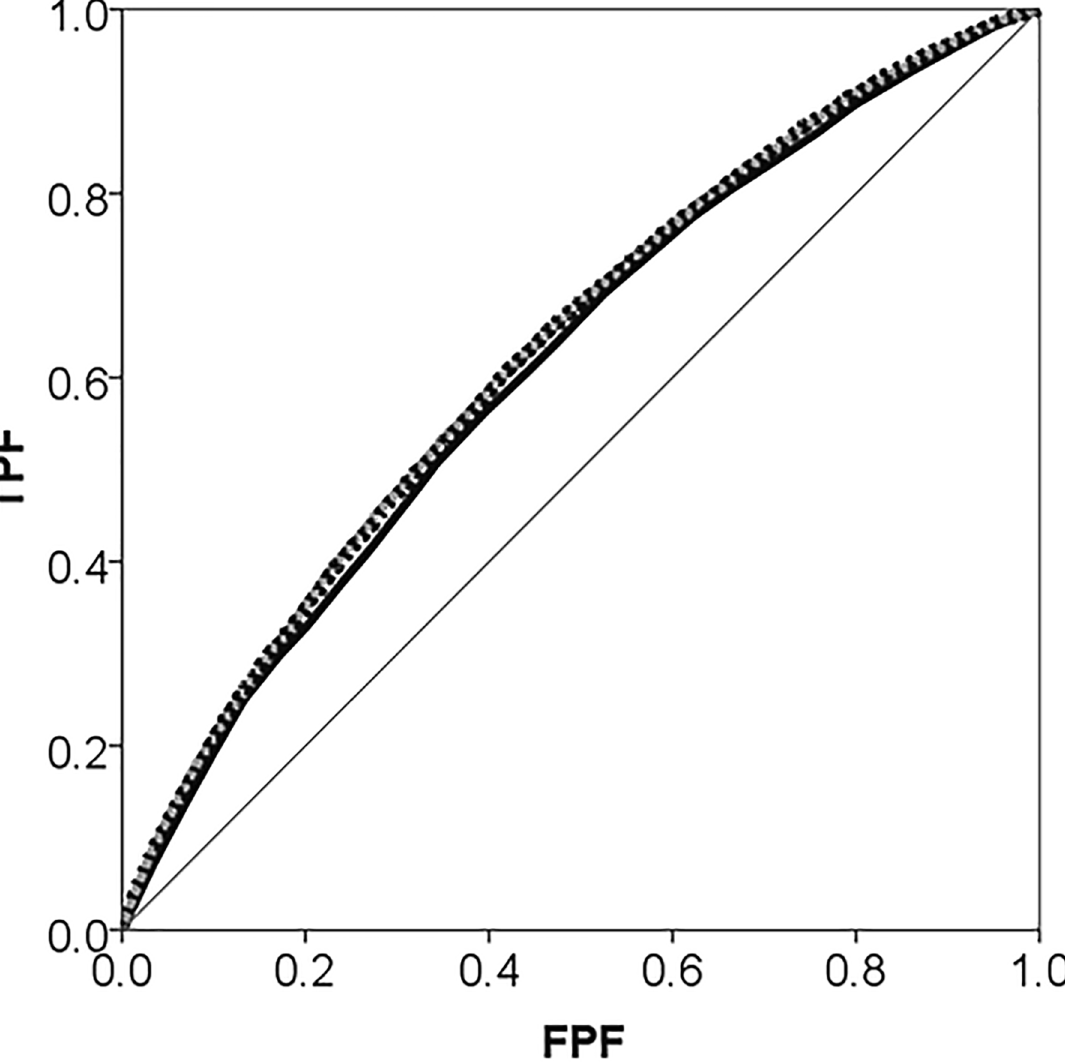
Fig 1. Areas under the receiver operating characteristic (AUC) curve for use of psychotropic drugs during 2006 in the city of Malmö, Sweden plotted separately for Model 1 which only adjusts for individual-level covariates age, sex and income (black thick line), and Model 2 which additionally adjust for neighbourhood of residence (grey dotted line). The diagonal line represents an AUC equal to